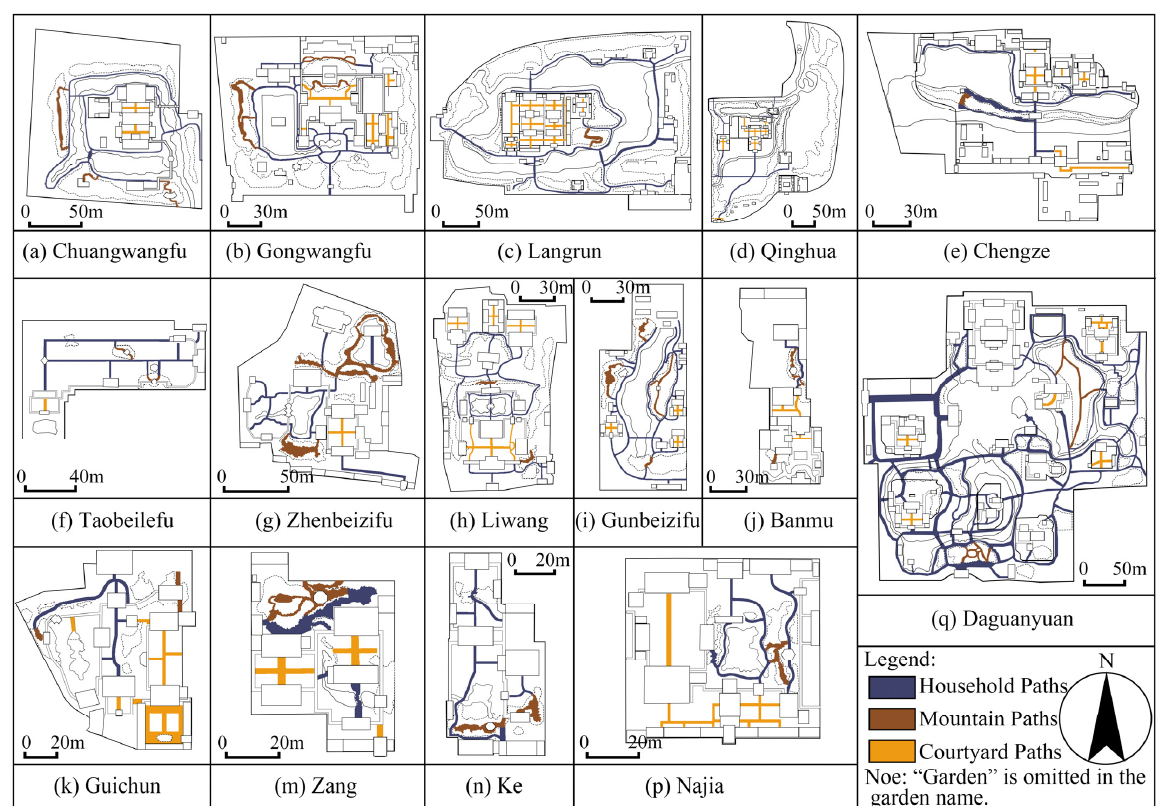
Figure 2. Distribution of research objects in Beijing.